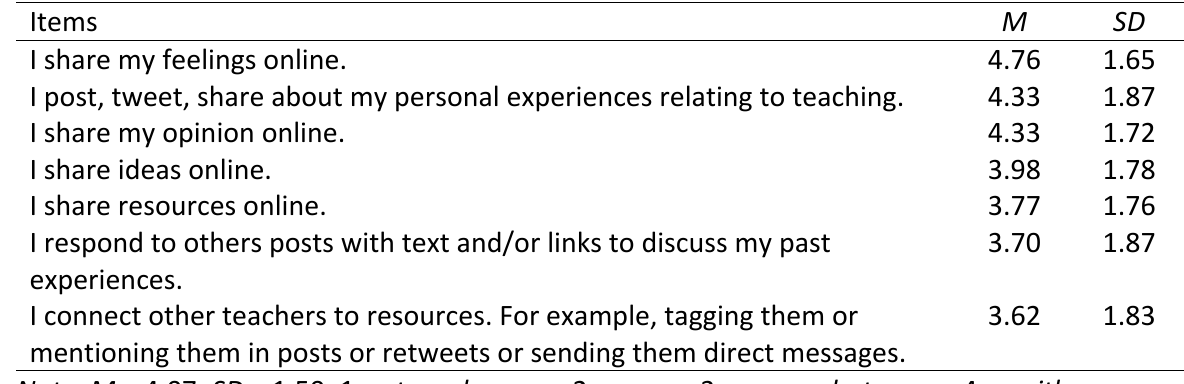
Descriptive Statistics for Sharing (N =